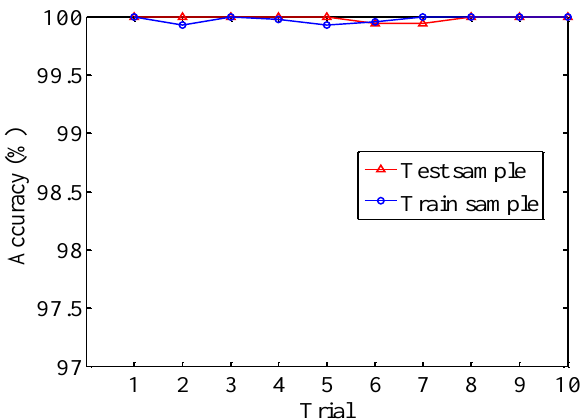
Figure 20. Curves of training and testing accuracy in 10 trials.